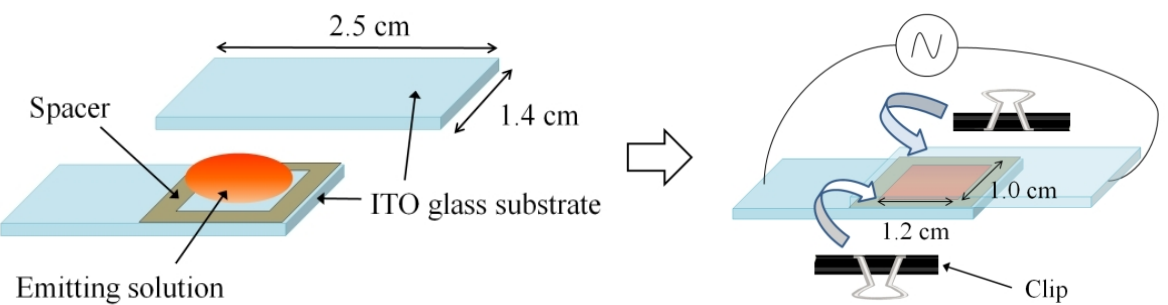
Figure 1. Schematic illustration of the electrochemiluminescence (ECL) device’s structure and